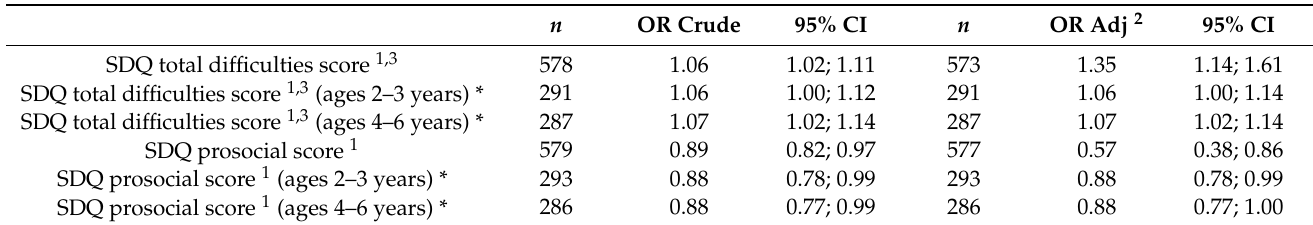
Table 2. Odds for ranging from not picky to picky in relation to the SDQ-TD and the PSB. n OR Crude 95% CI n OR Adj 2